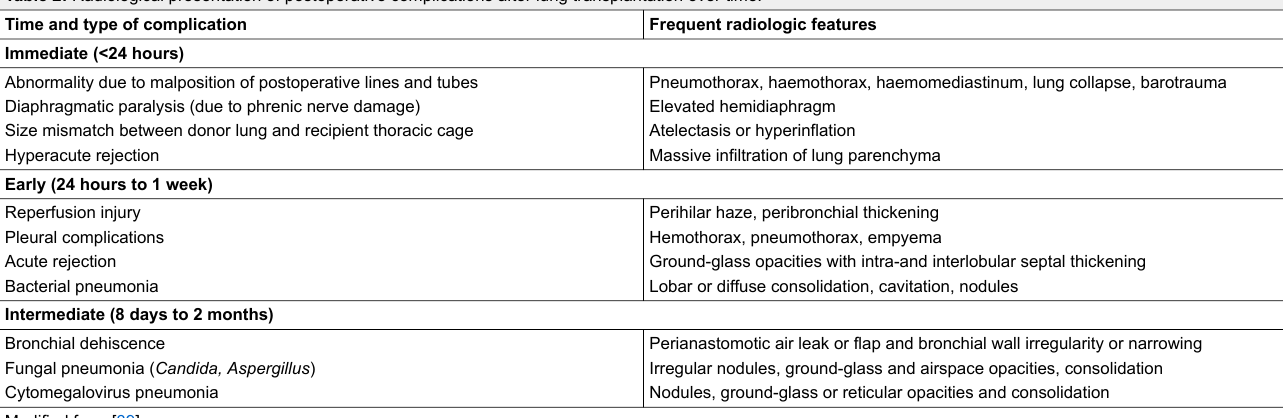
Table 2: Radiological presentation of postoperative complications after lung transplantation over time. Time and type of